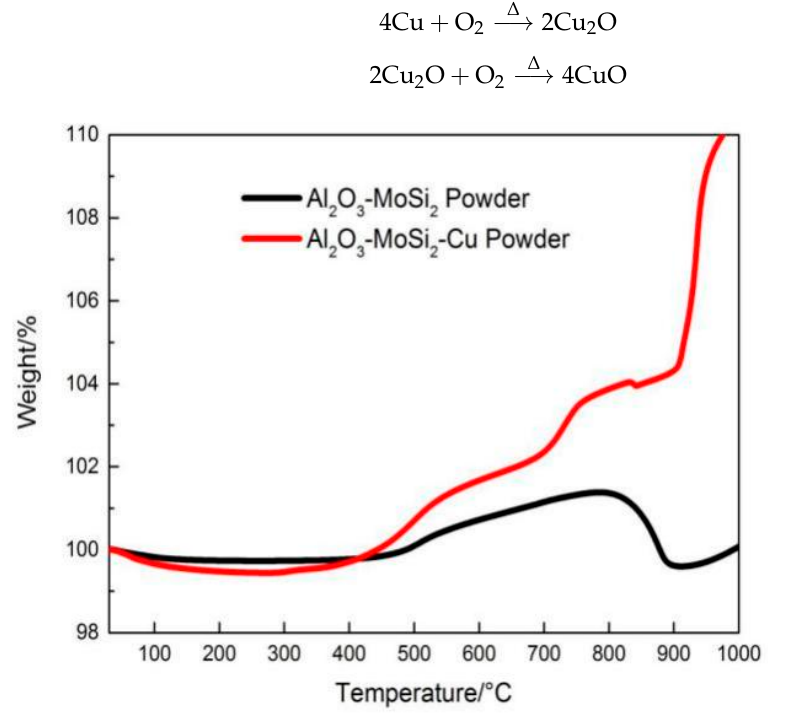
Figure 5. Thermogravimetric curve of Al 2 O 3 -MoSi 2 powder and Al 2 O 3 -MoSi 2 -Cu powder. The thermogravimetric curves show that Al 2 O 3 -MoSi 2 powder can increase the high- temperature oxidation resistance of the material. The CuO [26] and Cu 2 O formed by Cu oxidation at high temperature can improve the microwave absorption performance of the